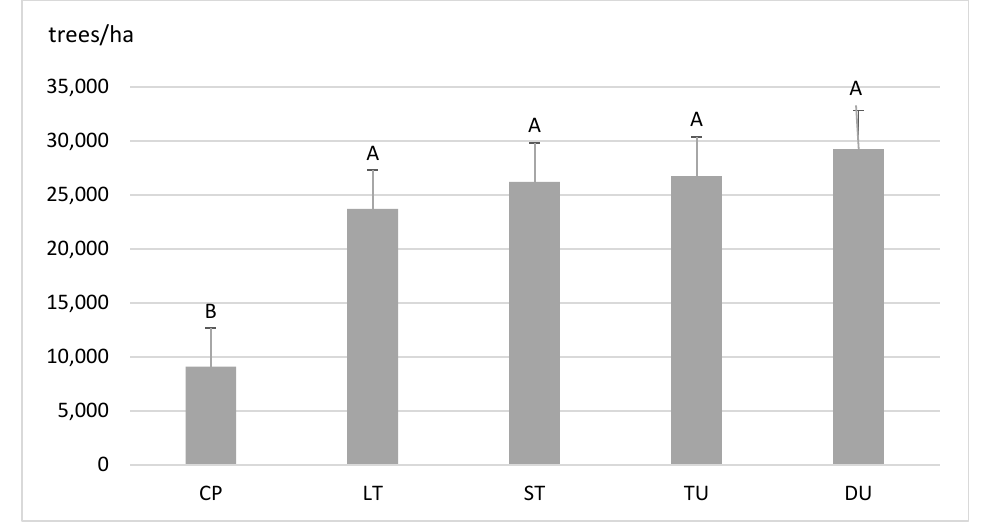
Figure 8. Average seedling (<0.25 m) density/ha for the different treatments. Different capital letters indicate significant differences among treatments in 2019.